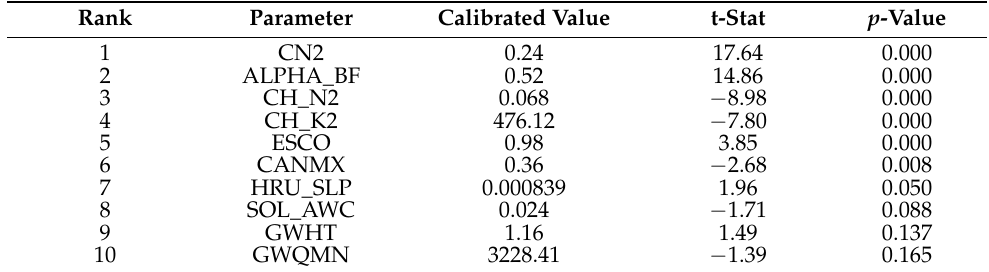
Table 2. Parameters used in streamflow calibration.